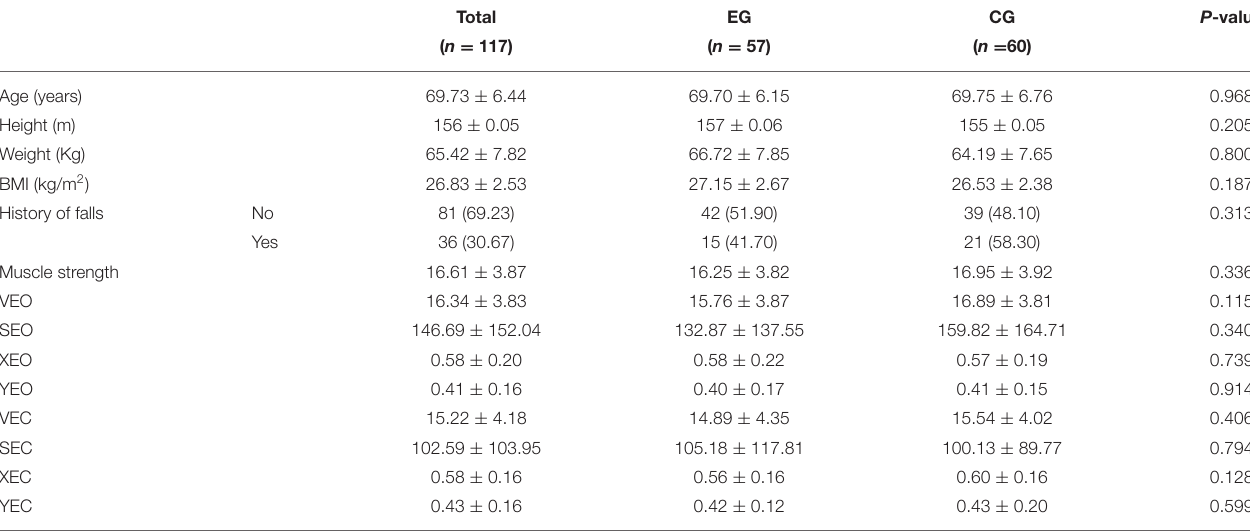
TABLE 1 | Baseline characteristics of study